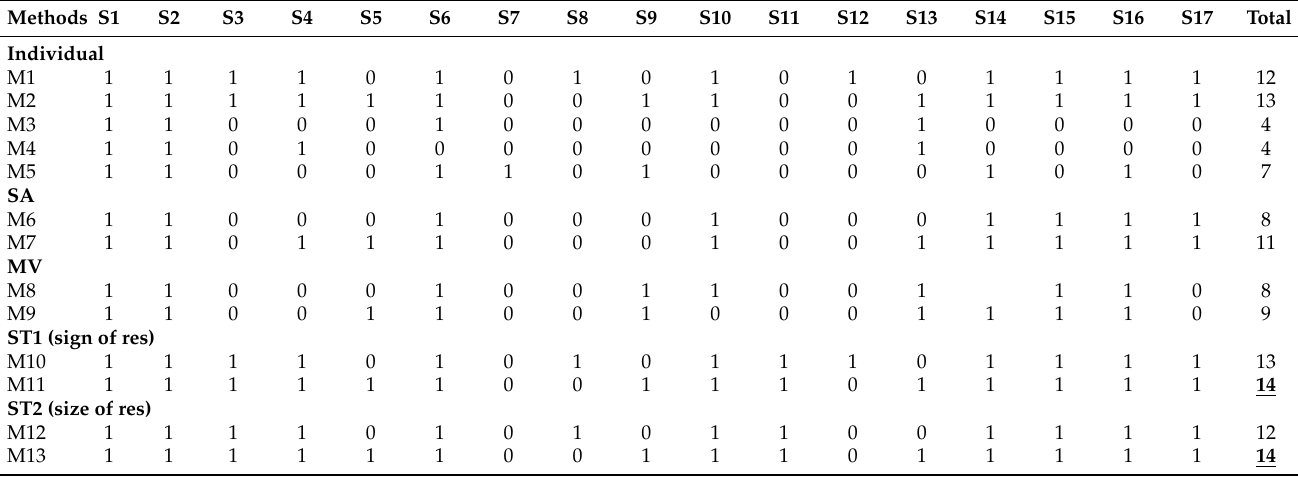
Table 16. MCS test for out-of-sample in tourism demand volatility forecasting using squared forecast